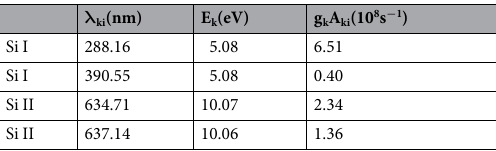
Table 2. List of spectral lines used for temperature calculation.